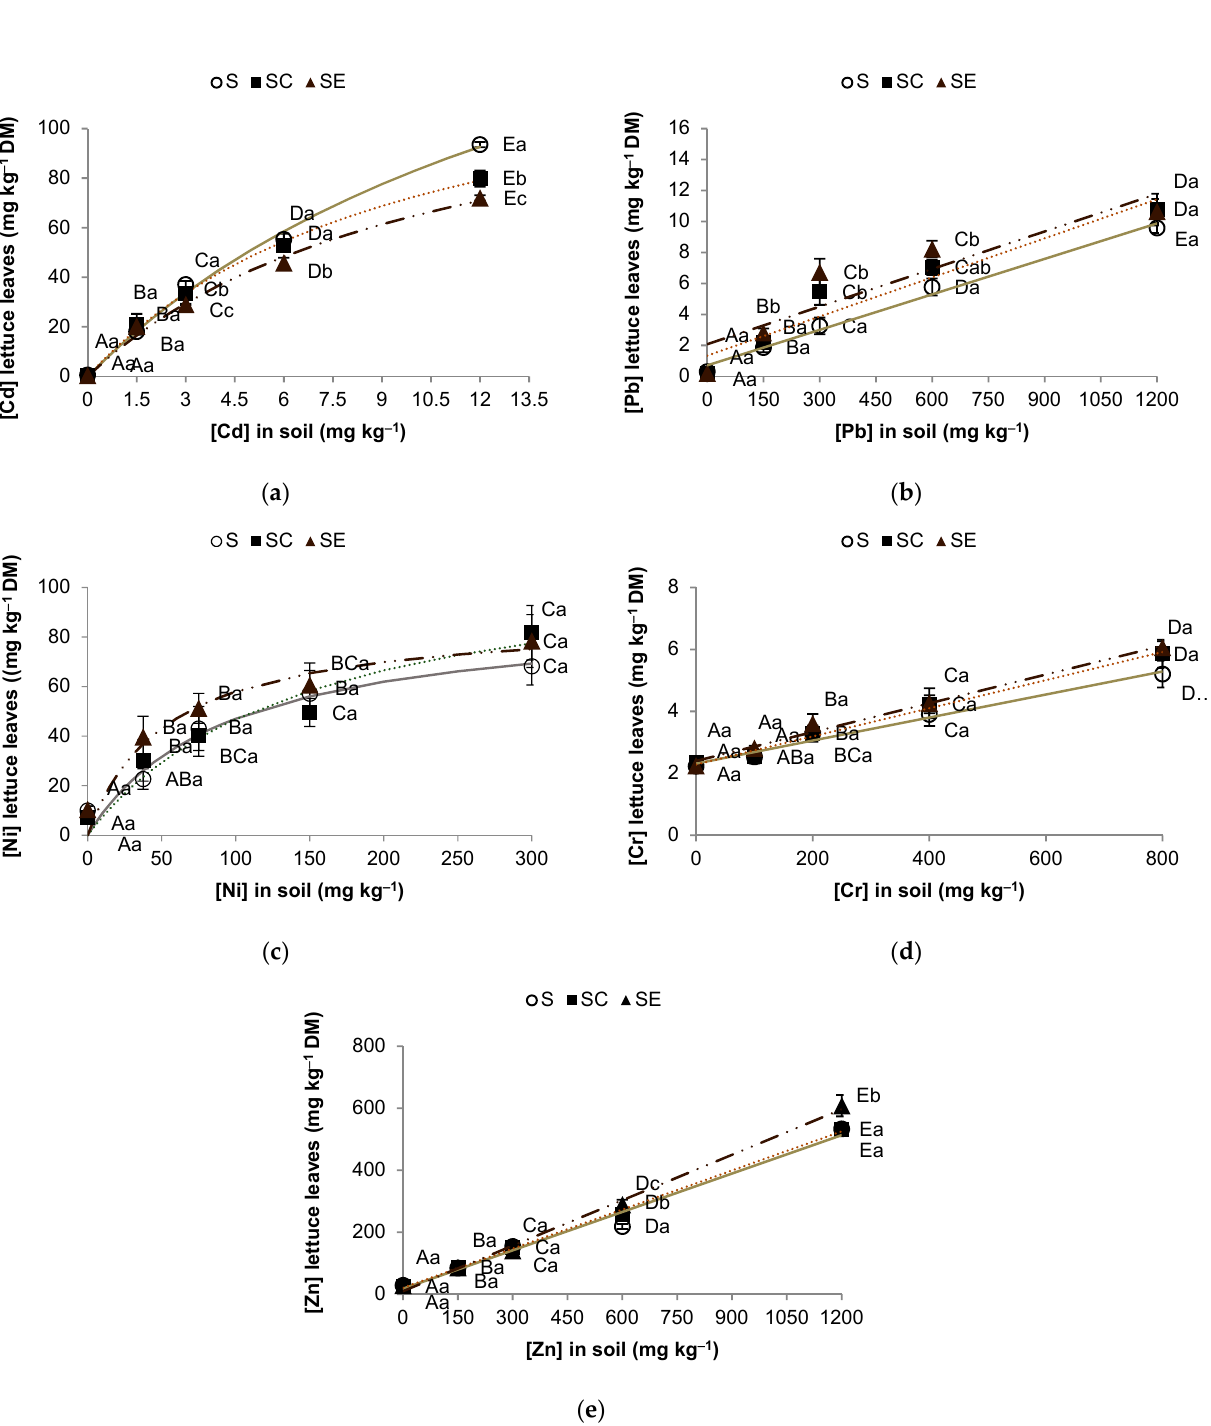
Figure 1. Accumulation curves of PTE content in lettuce leaves of plants growing in non-amended soil (S), soil amended with cork powder (SC) and soil amended with horse manure (SE): ( a ) Cd; ( b ) Pb; ( c ) Ni; ( d ) Cr; ( e ) Zn.